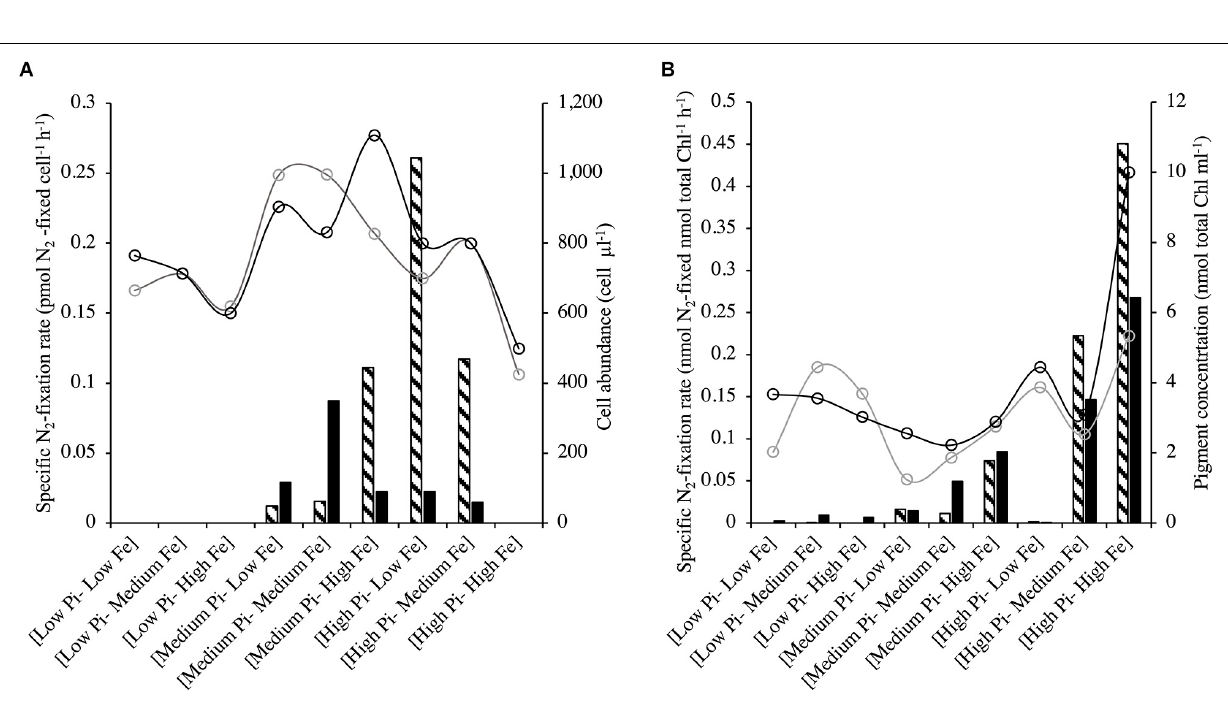
FIGURE 5 | N 2 -fixation rates for (A) Halothece sp. and (B) Fischerella muscicola at different combinations of PO 43 − and Fe concentrations. Halothece sp. were grown under [Low NO 3 − ] to promote N 2 -fixation. Bar graphics indicate N 2 -fixation, while empty circles indicate cell abundance (cell µ l − 1 ) for Halothece sp. and chlorophyll concentrations (nmol total Chl ml − 1 ) for F. muscicola . Data presented are actual values of the duplicates (striped and solid bars or light and heavy lined circles). PO 43 − is represented as